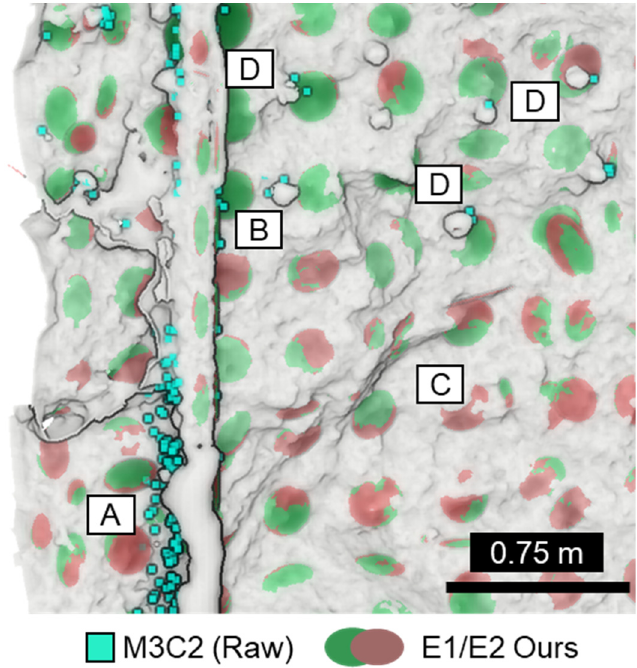
Figure 11. A close-up view of Region C in Figure 10a showing covariance per voxel as green and red ellipsoids for Epochs 1 and 2, respectively. Meshing also performs poorly on the wooden beam (B). M3C2 produces false positives around the wooden beam (A) and rock bolts (D) due to unfavorable incidence angles and occlusion. A good fit of covariance ellipsoids to the beam’s flat surface and the rough surface of the drift wall (C) can be observed. A good match between E1 and E2 ellipsoids results in a low false-positive rate.